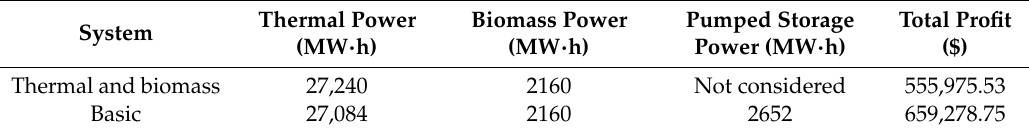
Table 6. The power output comparative results in both